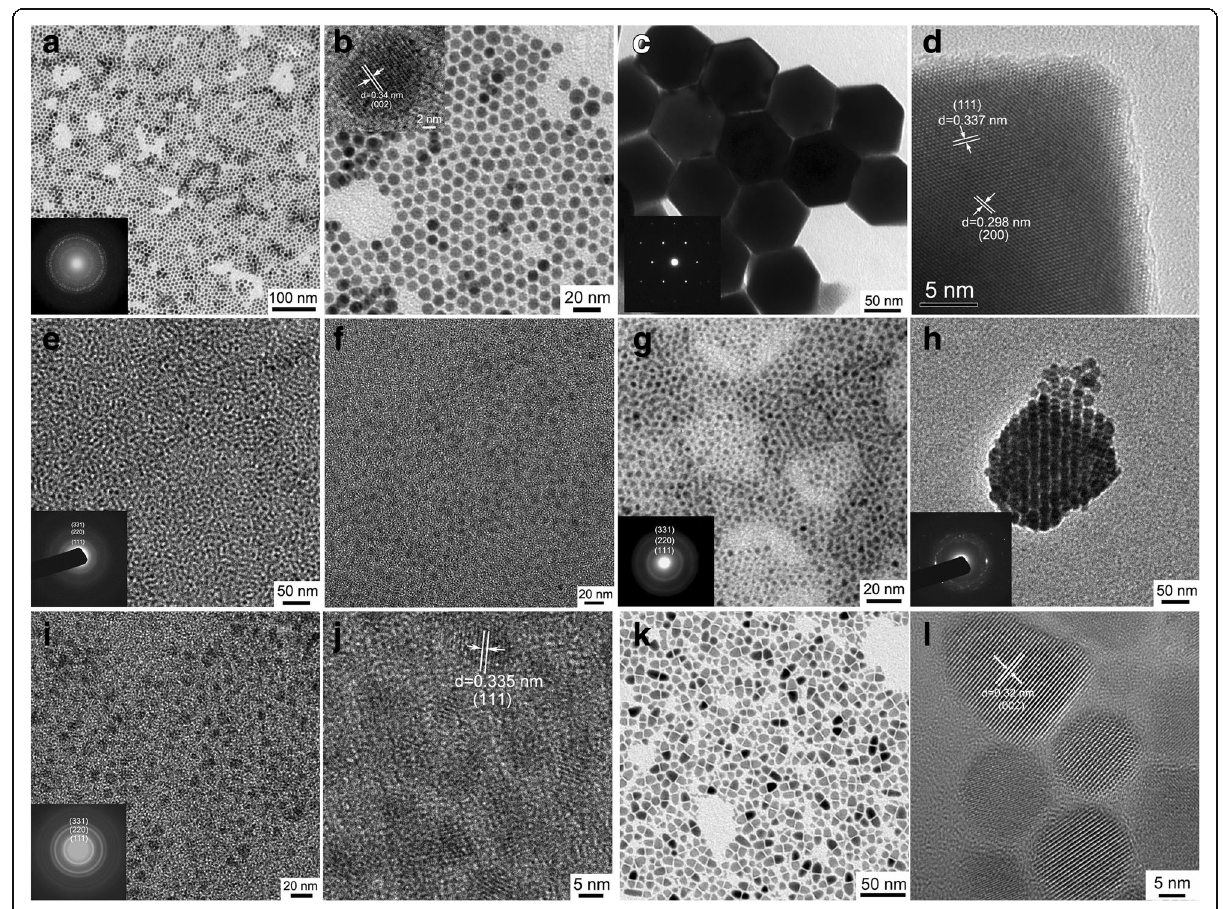
Fig. 6 TEM images of the as-collected different products. a , b Cu 2 S. c , d PbS. e , f CdS. g ZnS. h Ag 2 S. i , j CdS:Cu(I). k , l CuInS 2 . The insets of a , c , e , g , h , and i are the corresponding SAED patterns, and the inset of b is the corresponding HRTEM